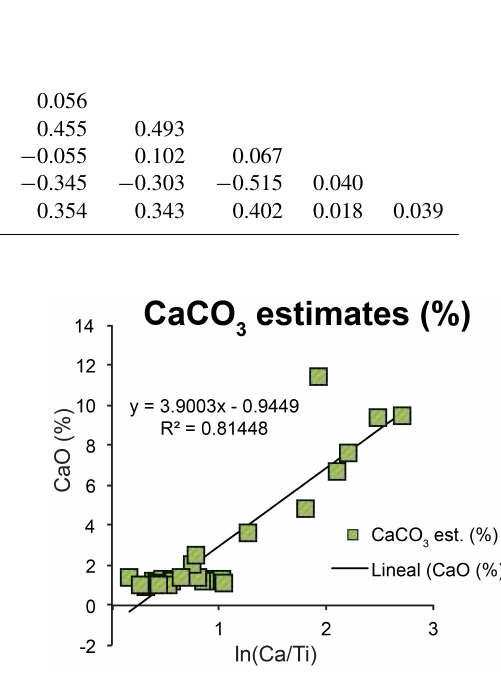
Figure 5. Linear correlation between CaO% (discrete XRF) and ln(Ca / Ti) (XRF scanner) values in order to estimate carbonate con- tents (CaCO 3